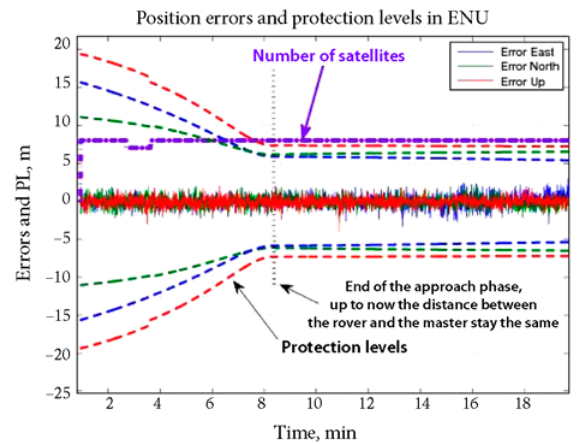
Fig. 6. Errors and protection levels in ENU for the simulated trajectory without smoothing. The number of visible satellites has been